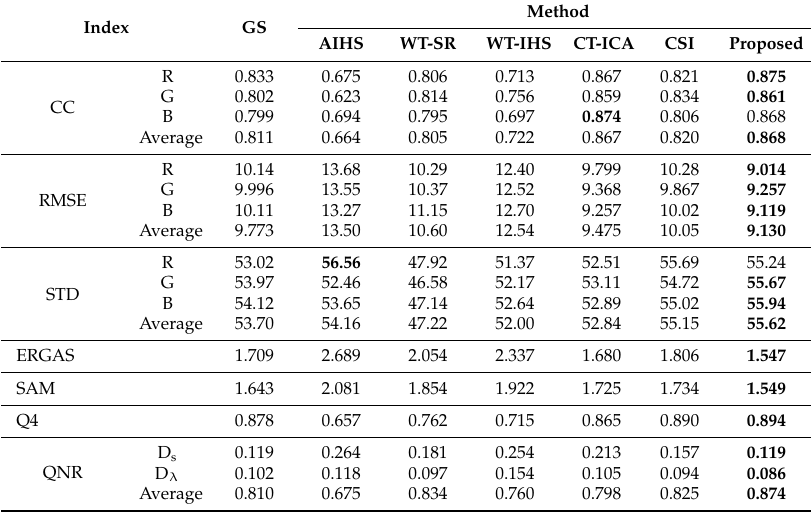
Table 3. Evaluation indices of fusion results for Pleiades data.